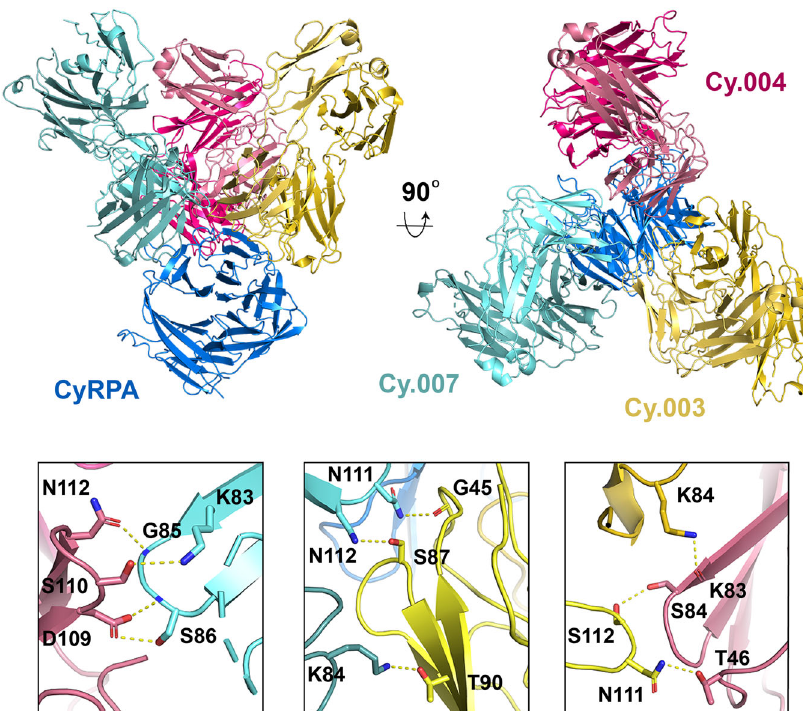
Fig. 6 Synergy between different antibody pairs is mediated through lateral heterotypic interactions. Crystal structure of CyRPA (blue) bound to Fab fragments of Cy.003 (yellow), Cy.004 (pink), and Cy.007 (light blue). The lower panels show close-up views of each of the interfaces between Cy.004 and Cy.007 (left), Cy.003 and Cy.007 (centre), and Cy.004 and Cy.003 (right). The residues forming heterotypic interactions are labelled and bonds are indicated with yellow dashed